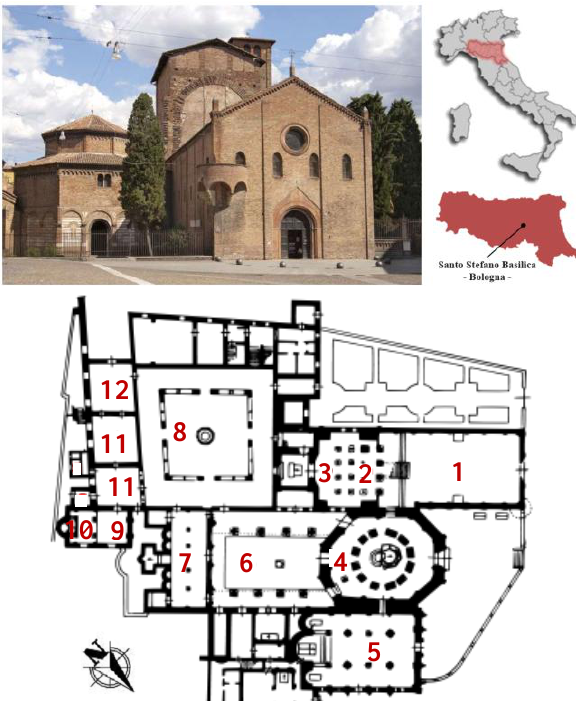
Figure 2. The Basilica of St. Stefano, Bologna (Italy). Picture of the front view from St. Stefano Square (top left); location map (top right); map of the numerous religious buildings characterizing the monument (bottom).